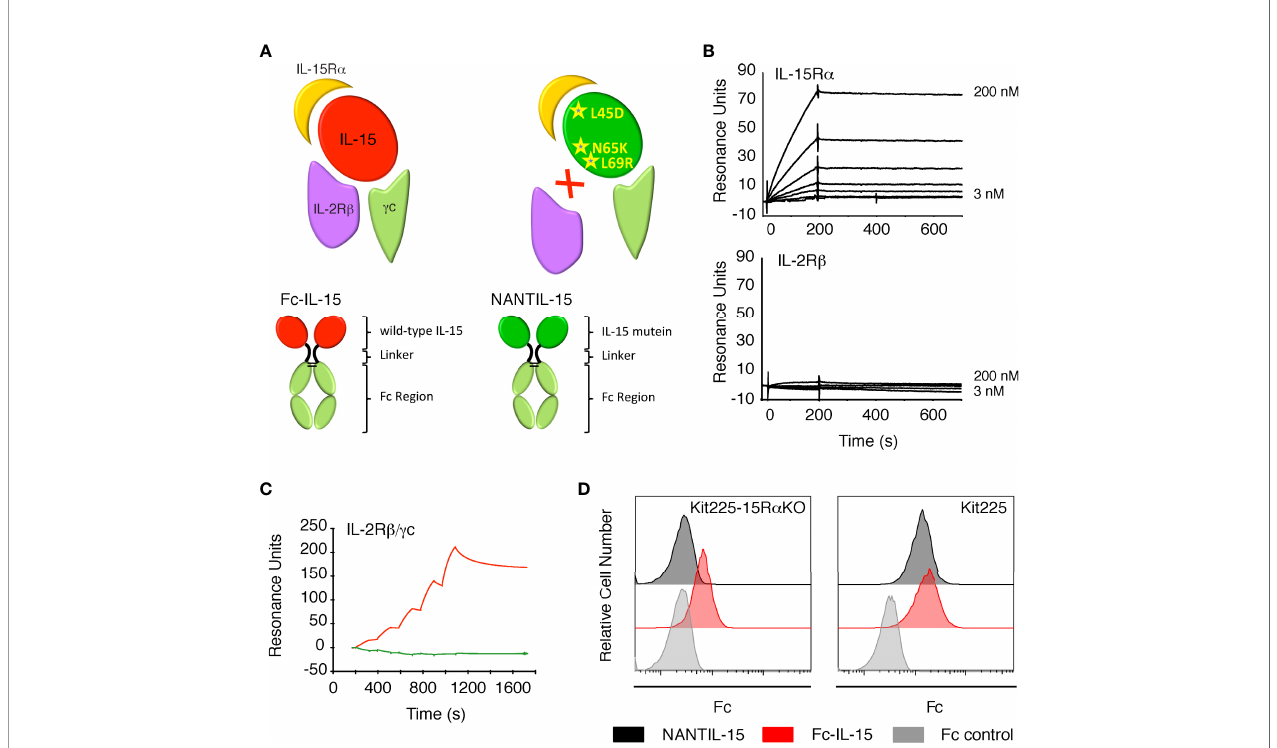
FIGURE 1 | Binding of NANTIL-15 on IL-15 receptors. (A) Top panels: diagram showing wild-type IL-15 (red) or IL-15 mutein (green) bound to its three receptor chains IL-15R a , IL-2R b , and g c. Bottom panels show the Fc-IL-15 and NANTIL-15 molecules. (B) SPR sensorgrams of the binding of increasing concentrations of NANTIL-15 to immobilized IL-15R a (upper panel) or IL-2R b (lower panel) chains. (C) SPR sensorgram of the binding of increasing concentrations of NANTIL-15 (green) or Fc-IL-15 (red) to immobilized Fc-IL-2R b / g c proteins. (D) Binding of NANTIL-15 on Kit225 (expressing IL-15R a , IL-2R b , and g c) or Kit225-15R a KO (expressing IL-2R b and g c) cells, revealed by fl ow cytometry. All data are representative of at least three separate